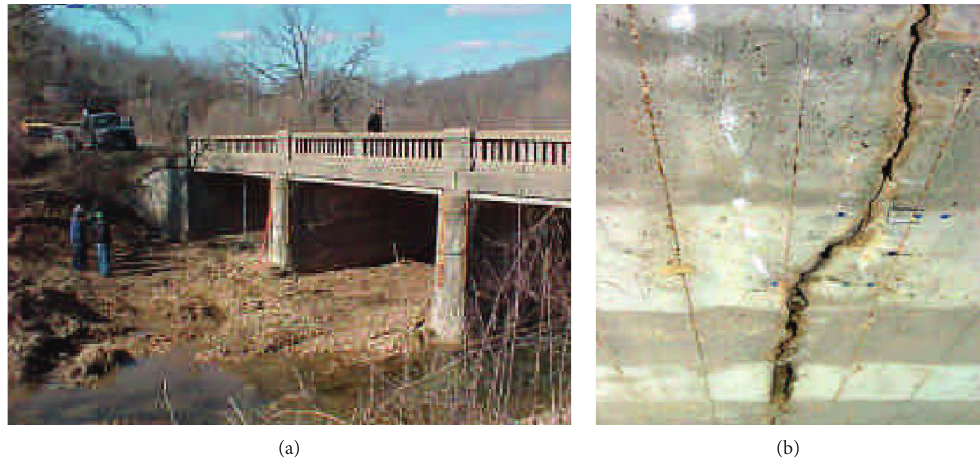
Figure 7: Martin Spring Bridge (a) and its soffit slab longitudinal crack (b) [140].